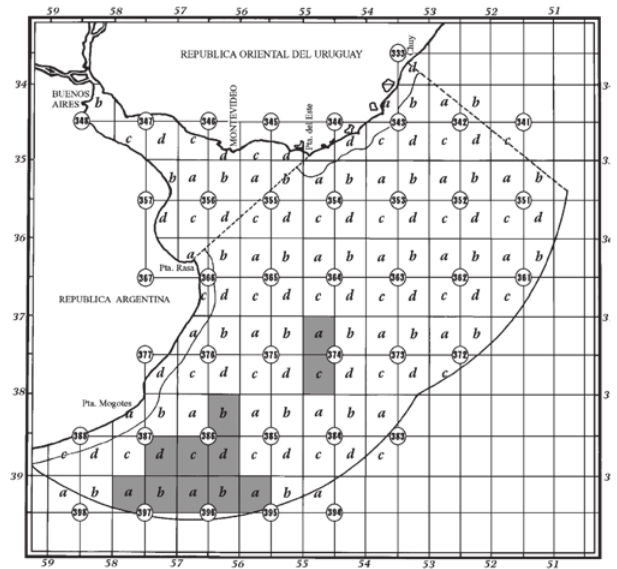
Fig. 1. Map of the study area; the Argentinean-Uruguayan Common Fishing Zone, Southwestern Atlantic Ocean. Shaded squares represent the operative fishing areas (each one con- sisting of sub-areas a, b, c and d) from where samples of Dipturus chilensis were